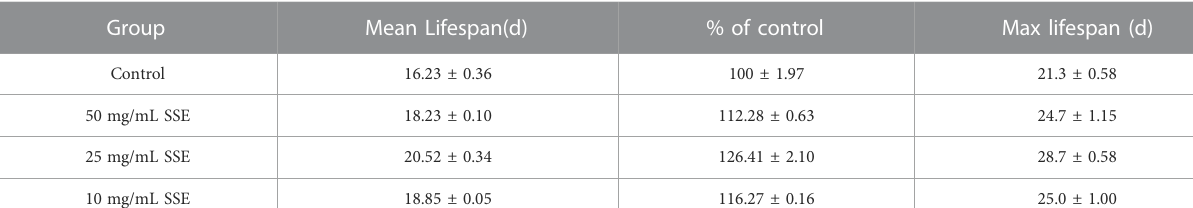
TABLE 1 Effects of SSE treatments on the lifespans of Caenorhabditis elegans (mean ± SD, n = 3).